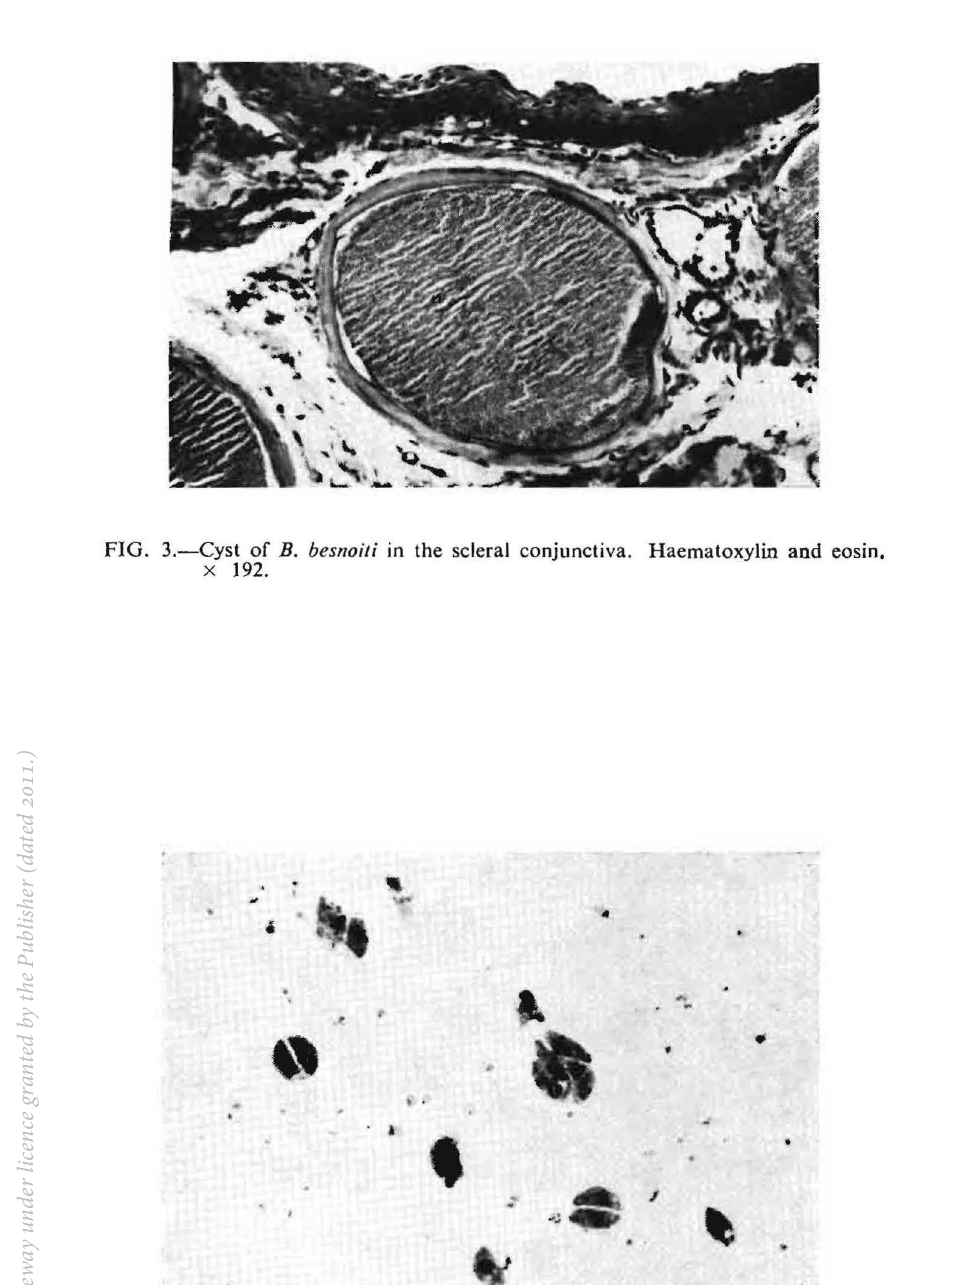
FIG. 4.-Cyst organisms of B. besl/oili from a ruptured cyst from the scleral con junctiva, stained after Giemsa. x